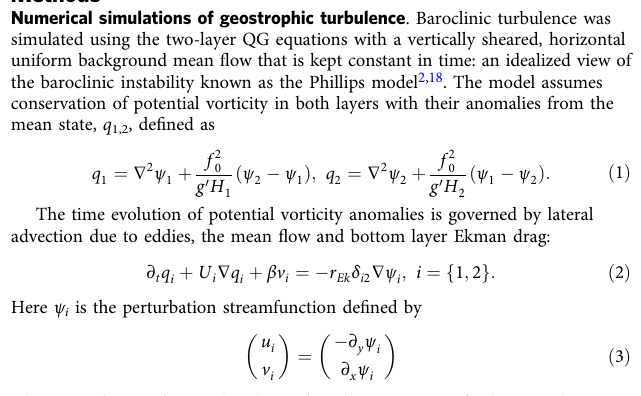
Fig. 5 Performance chart for a set of various data-driven techniques used to estimate eddy heat fl uxes from sea surface height snapshots. The y - axis represents their obtained skill and each column has a denoted value of R 2 that re fl ects the fraction of the total eddy fl ux variance explained by the fi t. The following techniques are shown: Linear Regression, Random Forrest, Principle Component Analysis (PCA), Support Vector Machine (SVM), Fully Connected shallow Neural Network (FC NN), Convolutional Neural Networks with sequential propagation (VGGNet) and with residual connections (ResNet). The techniques are described in Methods. Convolutional neural networks (dark blue) signi fi cantly outperform other methods (cyan) as they are optimized to extract the most informative eddy patterns. Note that the FC NN and VGGNet training time is O(1 cpu hour), whereas ResNet takes O(1000 cpu hours) to